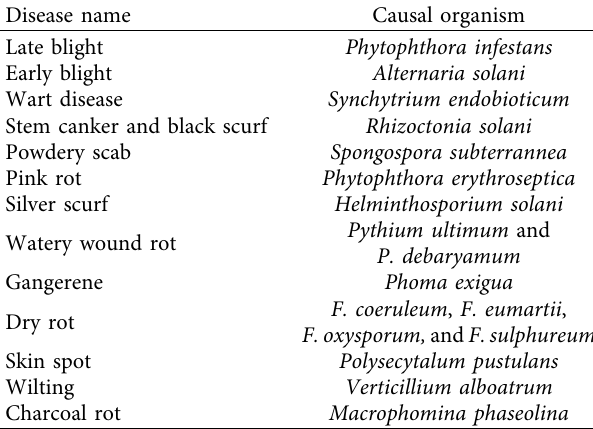
Table 1: Important fungal disease of